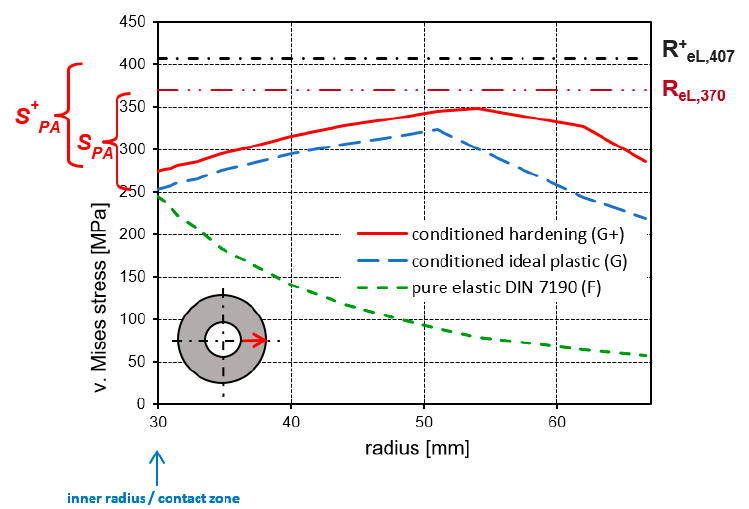
Figure 4. Von Mises stresses in the stress states of points F elast , G , and G + with a safety against the plastic deformation of the outer part S PA = 1.5 = S +PA ( S +PA after hardening of the material). In Figure 5, the radial stresses for points F elast , G , and G + are shown, which are identical to the magnitude of the joint pressure ( p F = −σ r = p i ) at the radius coordinate at 30 mm .